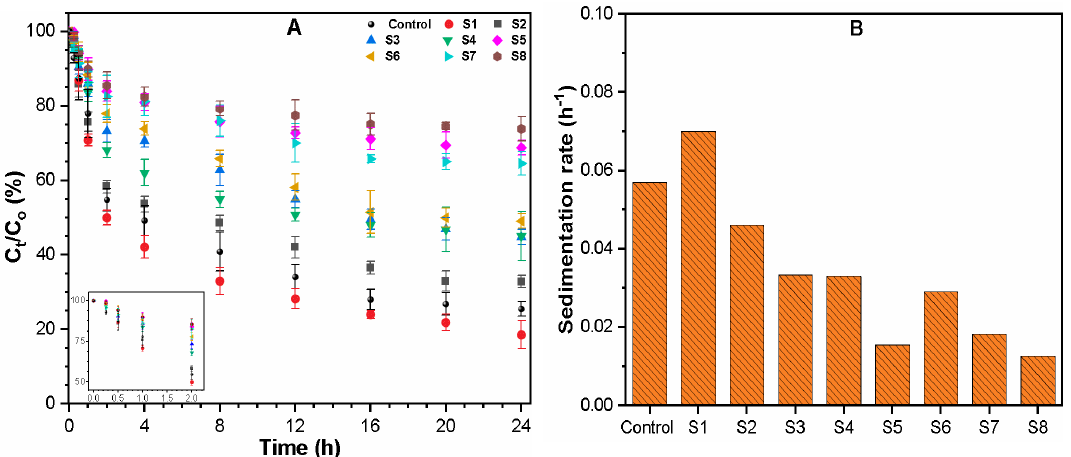
Figure 4. ( A ) Aggregation kinetic and; ( B ) sedimentation rates K (h − 1 ) of ZnO NPs (30 mg/L) suspension in various synthetic waters after 24 h respectively.